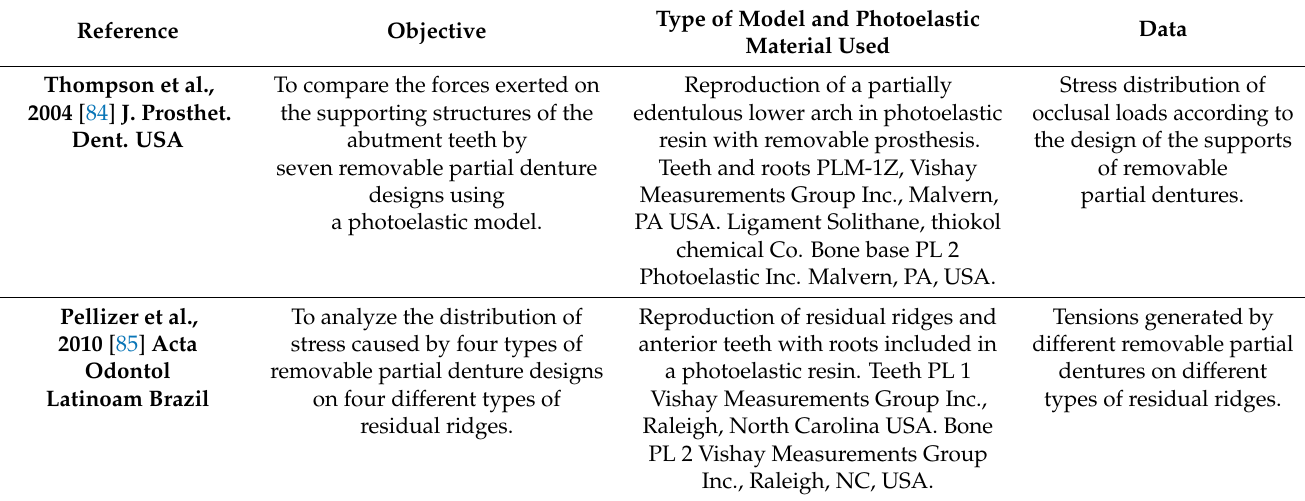
Table 8. Characteristics and findings of studies on removable partial dentures in the dental area.